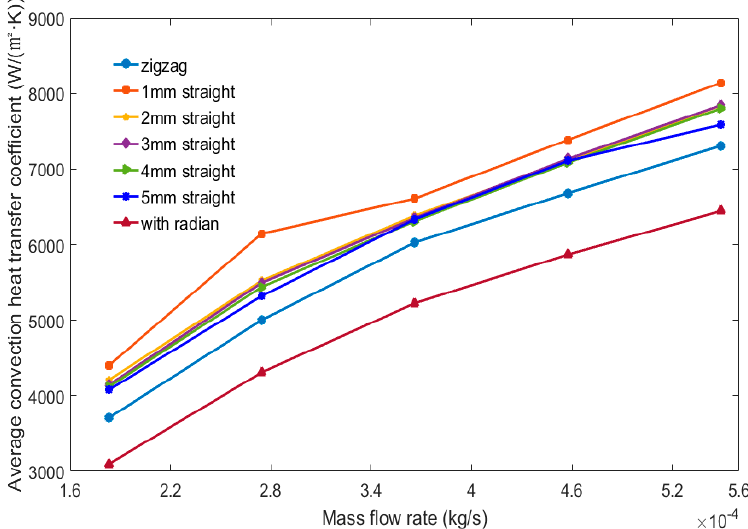
Figure 10. Average convection heat transfer coefficient of different channel shapes at different mass flow rates. Energies 2019 , 12 , x FOR PEER REVIEW